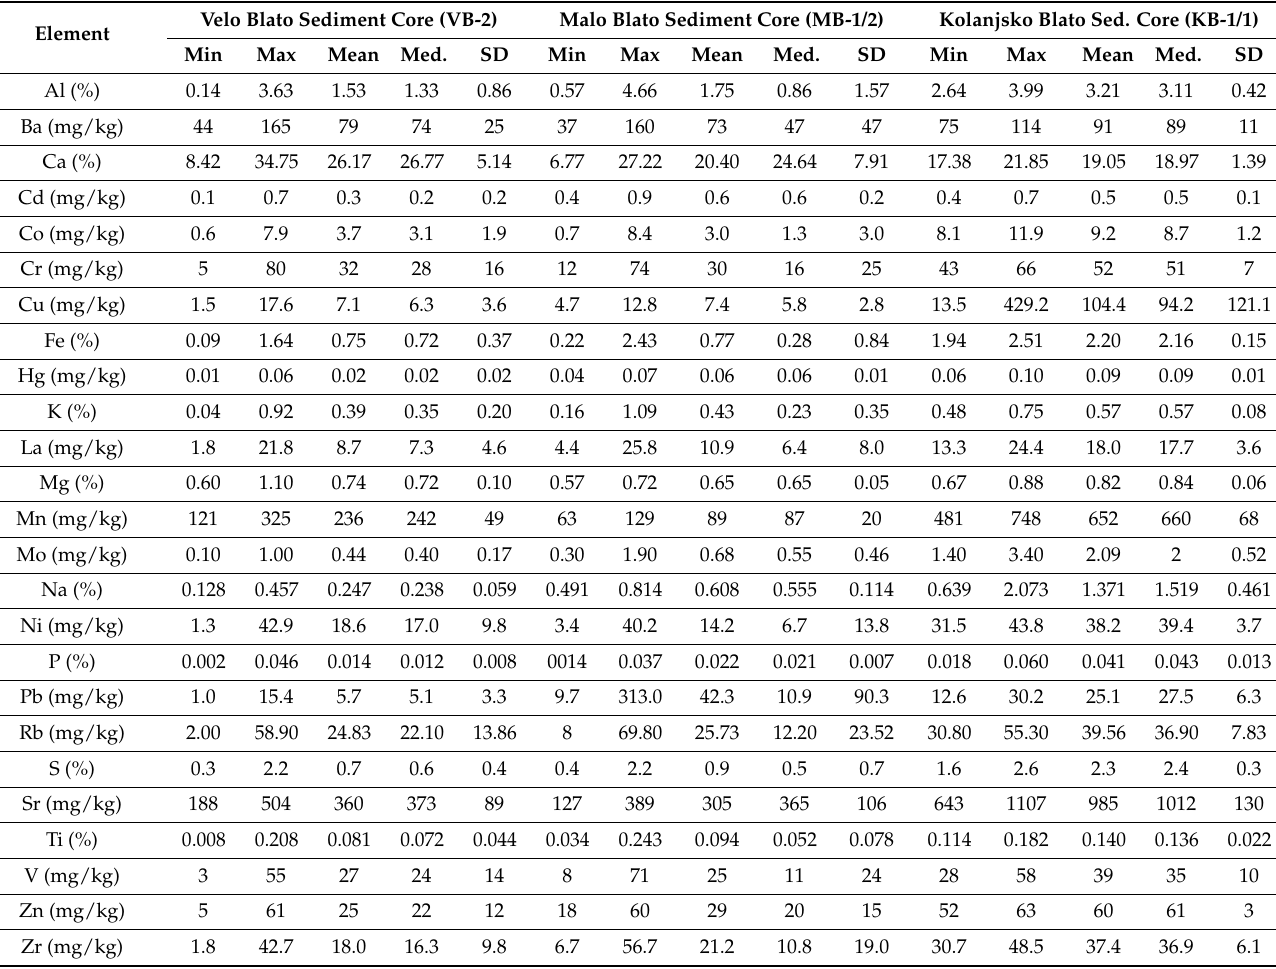
Table 3. Descriptive statistics of selected major and trace elements from sediments of Velo, Malo, and Kolanjsko Blato (minimum, maximum, mean, median, and standard